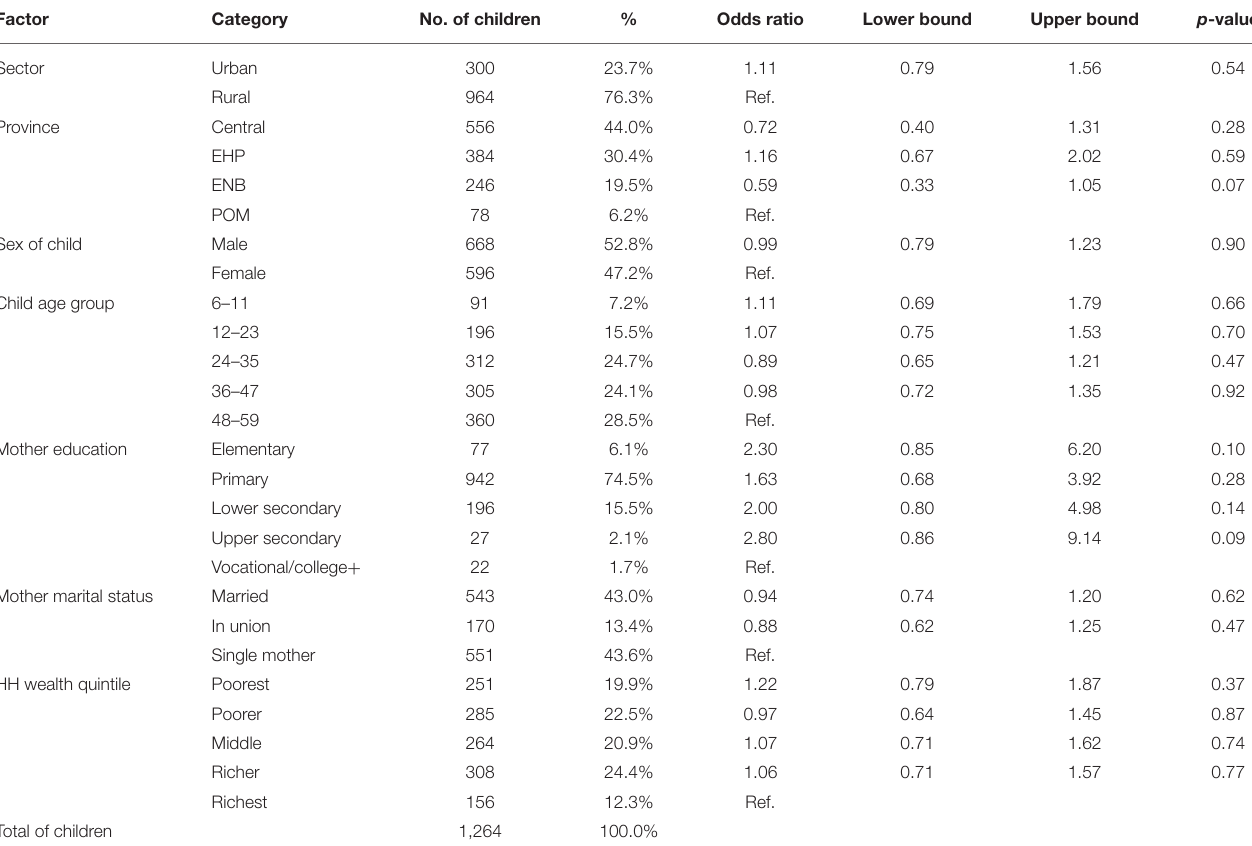
TABLE 5 | Odds ratio of having low level of total dietary diversity scores among children aged 6–59 months by household and maternal socioeconomic demographic factors in PNG, PNGIMR’s CHESS, 2020. Factor Category No. of children % Odds ratio Lower bound Upper bound p -value